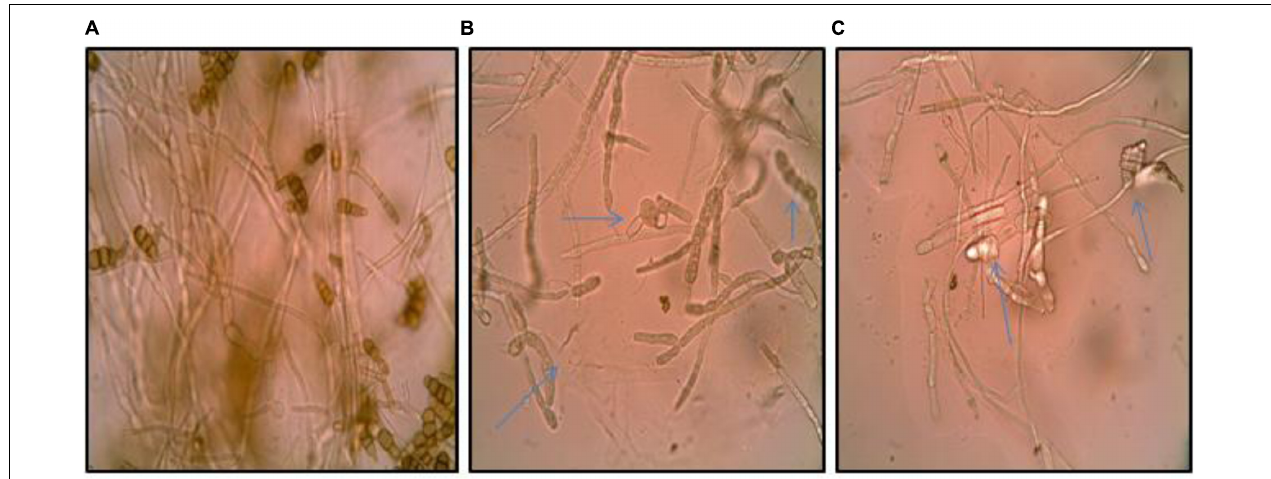
FIGURE 1 | Effect of culture supernatant of Streptomyces hydrogenans strain DH16 on Alternaria brassicicola mycelial morphology. (A) Firm control mycelium (B,C) treated hyphae. Arrows indicate abnormalities like distorted mycelial structure, swellings, leakage of cellular material, loss of pigmentation in mycelium.